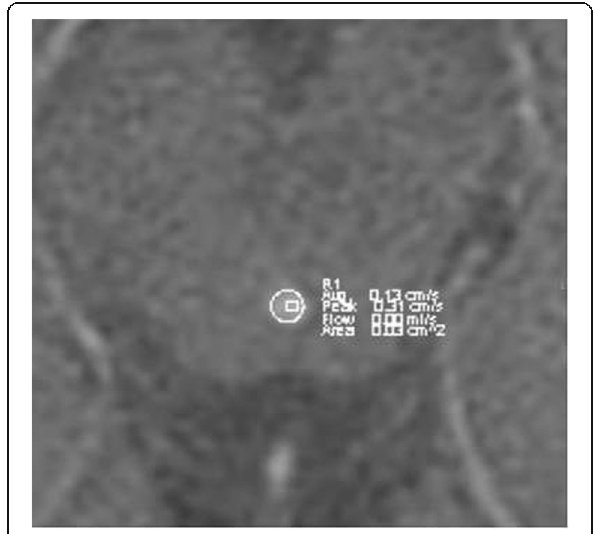
Fig. 5 Establishment of region of interest (ROI) that corresponds to cerebral aqueduct